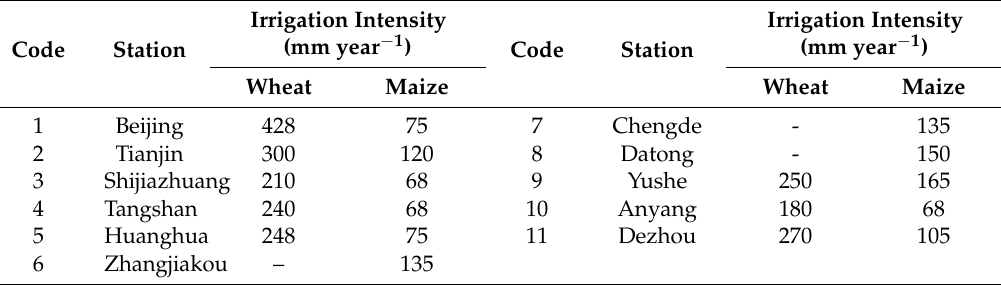
Table 3. Irrigation intensity [43] of wheat and maize within the